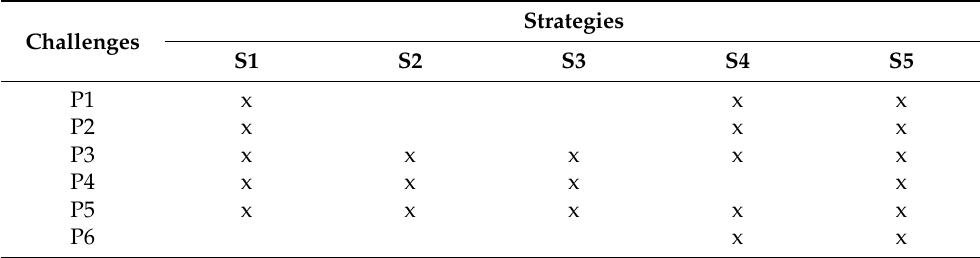
Table 5. Selection of strategy according to the type of